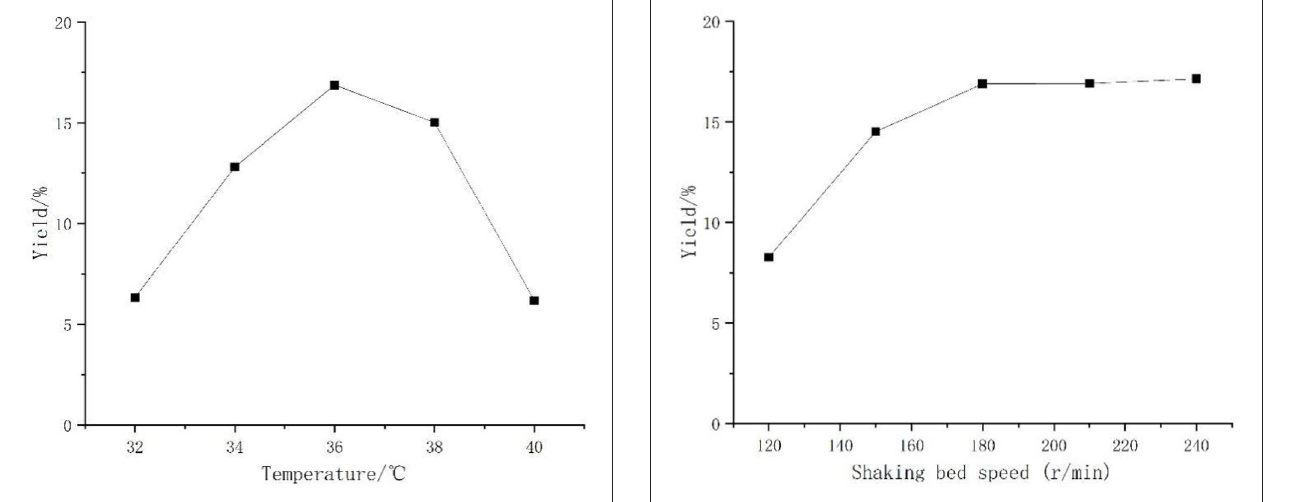
FIGURE 4 | Effect of shaking bed speed on the yield of Artemisia